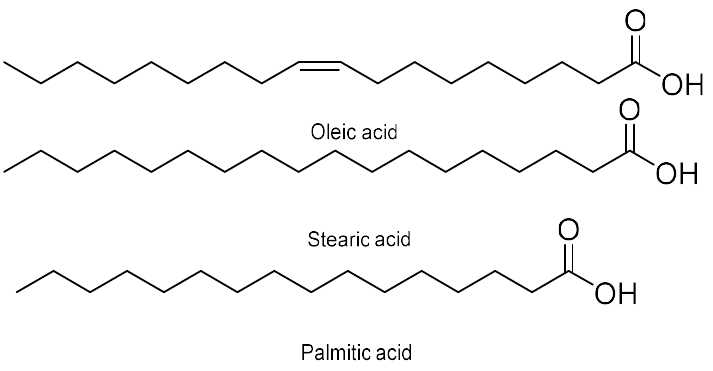
Figure 8. Metabolites in Carica papaya varieties Maradol, Mamey, Yellow, and Hawaiian with an